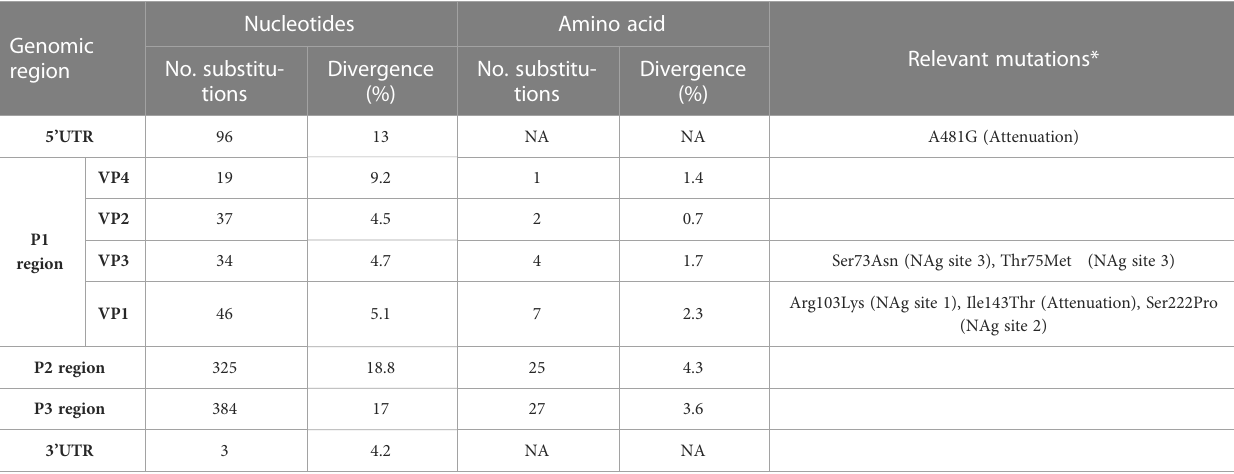
TABLE 1 Nucleotide and amino acid substitutions in strain SPA866 in comparison to Sabin 2.